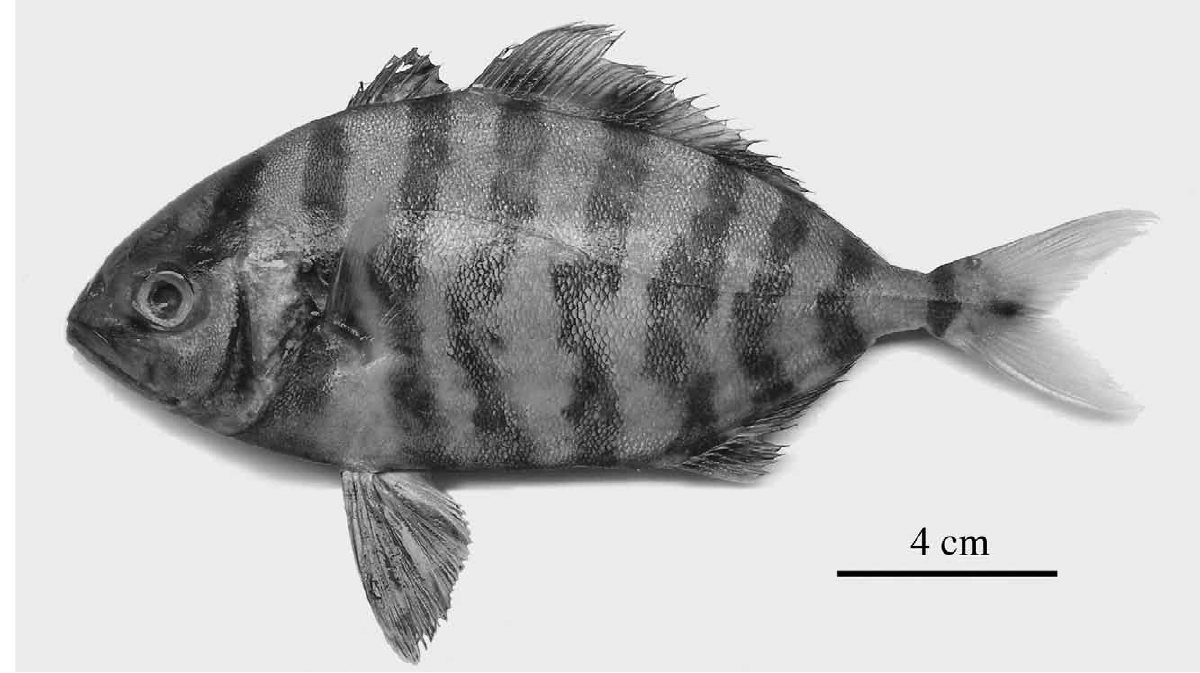
pA 65.7 SL. The body is elongated. The dorsal and anal fins are posterior in position and opposite, the caudal fin is lunate. Small spinules are present on the dorsal area, extending from behind the upper lip to the dorsal fin, while ventrally the spinules do not reach the anus. No scales are present on the rest of the body sur- face. Colour of defrosted specimen: dorsally it is grey- ish to greenish with circular or ellipsoid black spots. A silver band originates from behind the upper lip and extends to the caudal fin base. In front of and below the eye a silver blotch almost reaches 1/3 of the hori- zontal eye diameter. The belly is whitish. The pectoral base and inside of gills are black (Fig. 2).